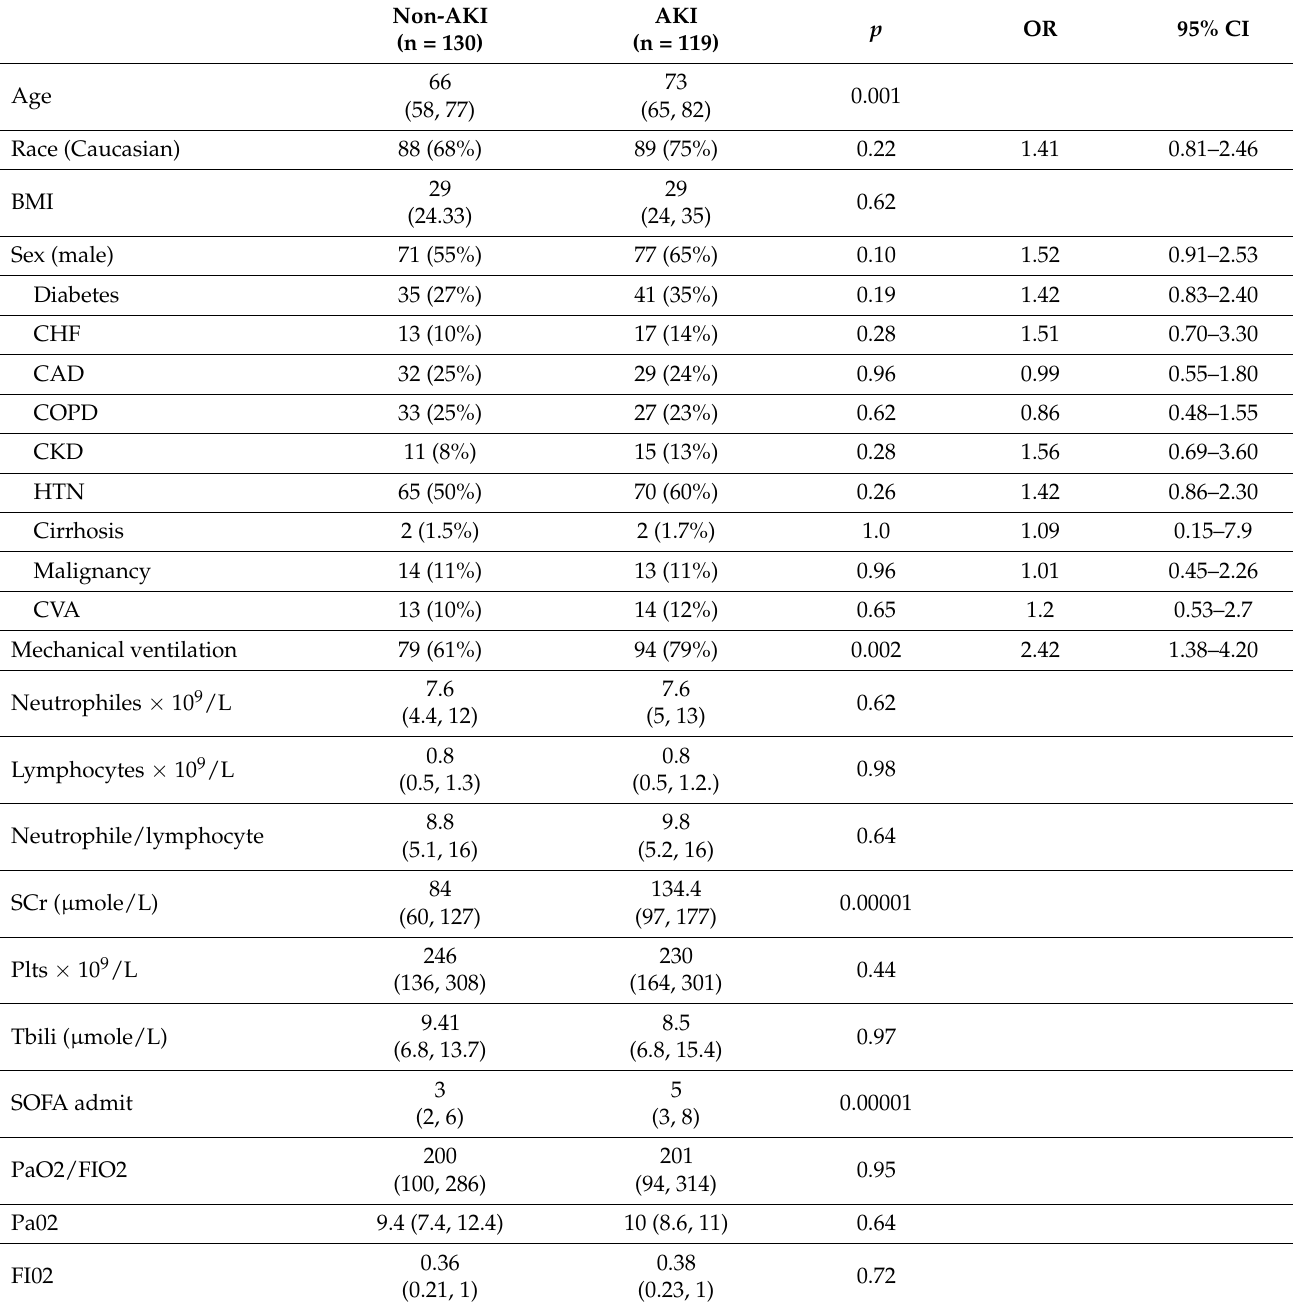
Table 1. COVID-19 ICU patients: characteristics of individuals with and without